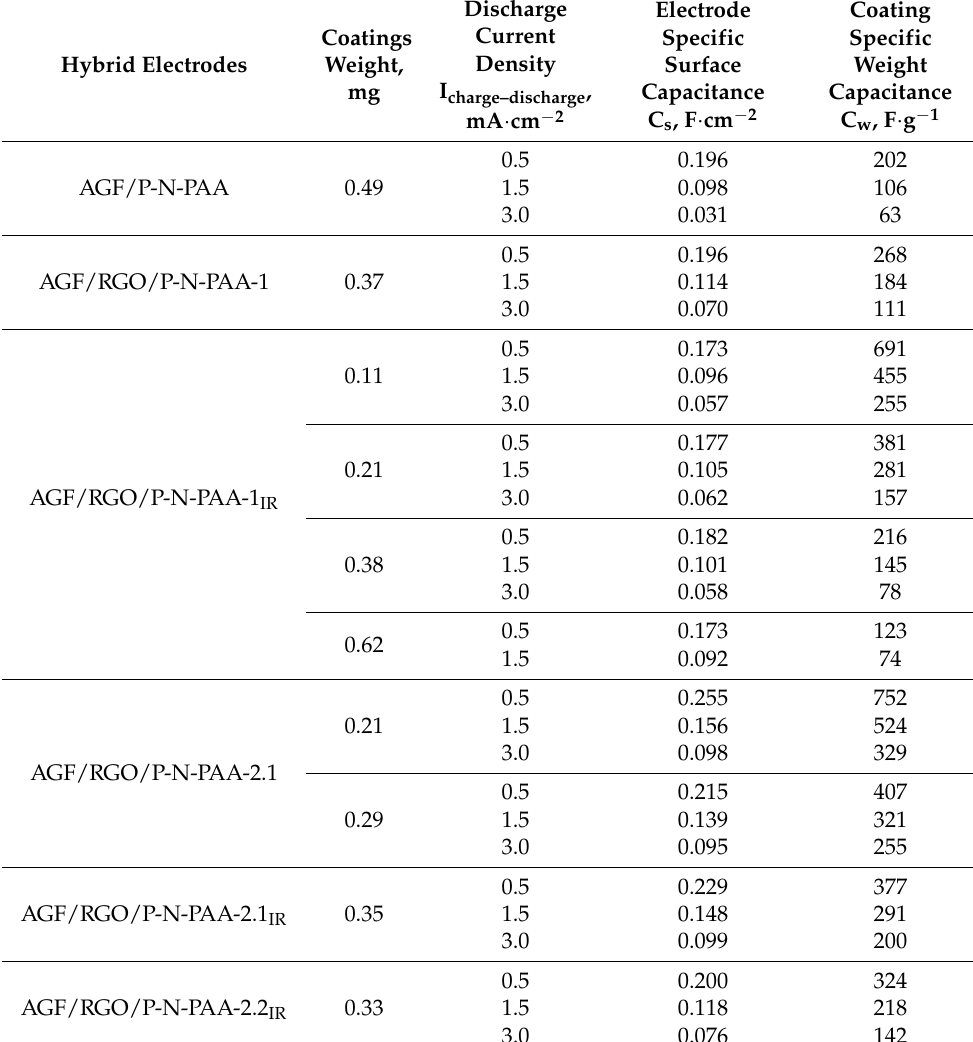
Table 5. Electrochemical characteristics of AGF/RGO/P-N-PAA electrodes in 1 M LiClO 4 in propylene